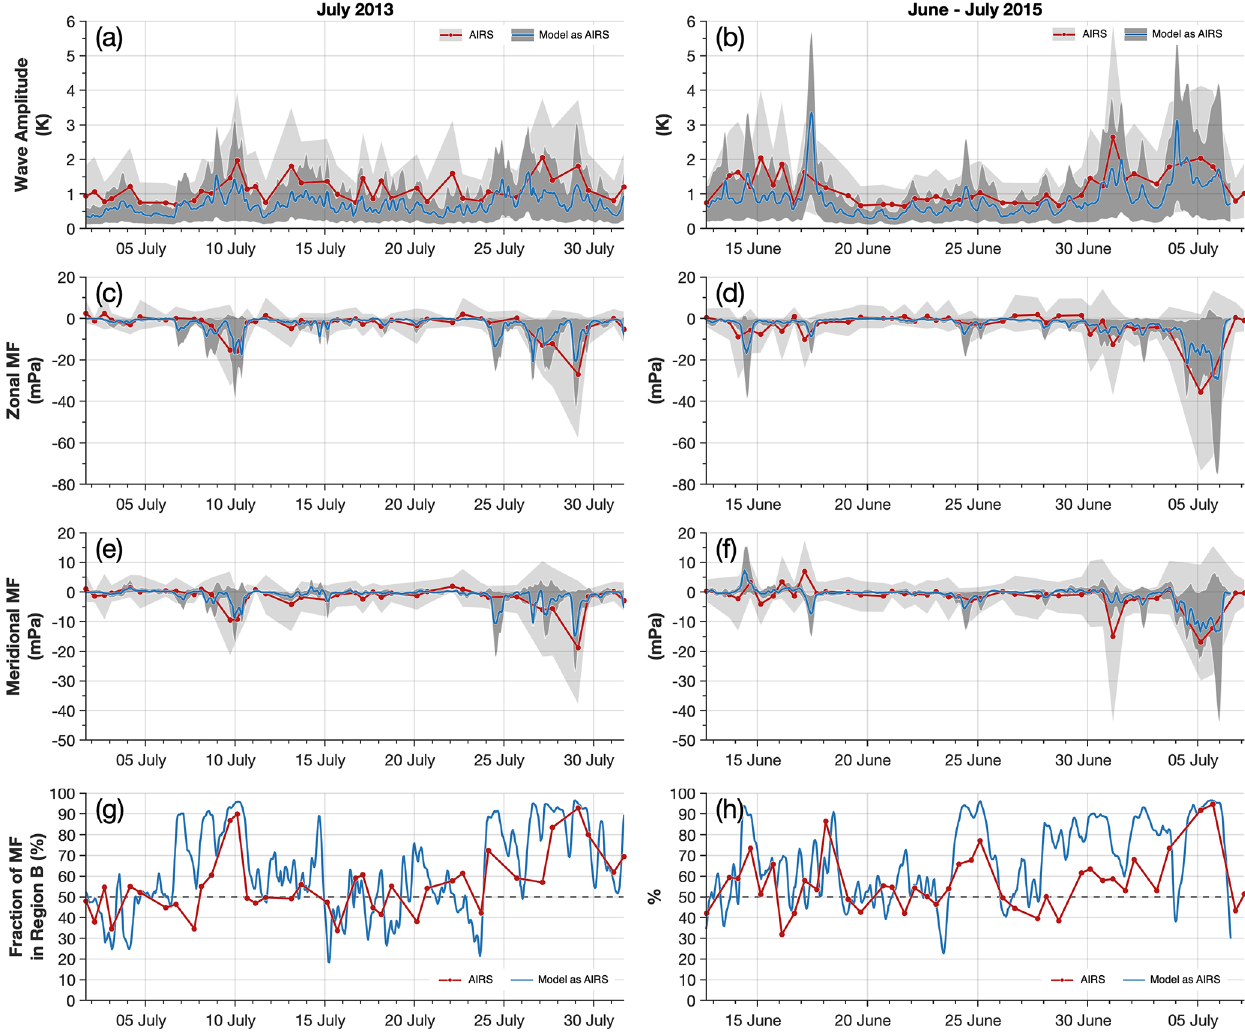
Figure 8. Time series of median GW amplitudes and net zonal and meridional momentum fluxes derived from AIRS measurements (red) and the model sampled as AIRS (blue) for July 2013 and June–July 2015. Values are averaged between altitudes of 25 and 45km over a horizontal region 600km × 400km centred on the island (region C in Fig. 4). Red circles show the overpass times of the AIRS measurements. Light and dark shaded grey areas show the 5th and 95th percentiles of measured wave amplitudes and momentum fluxes over the same region for AIRS and the model sampled as AIRS respectively. As in Fig. 2, panels (g and h) show the percentage of the total GWMF measured downwind of South Georgia (region B in Fig. 4). Percentage values larger 50% are a good indication of mountain wave